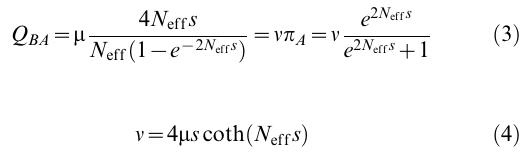
Figure S1 Phylogenetic tree of HA genomic segment for subtype H1. Avian section of the tree is in black, human in red. Found at: doi:10.1371/journal.pcbi.1000564.s002 (2.81 MB PDF) Figure S2 Phylogenetic tree of HA genomic segment for subtype H2. Avian section of the tree is in black, human in red. Found at: doi:10.1371/journal.pcbi.1000564.s003 (0.71 MB PDF) Figure S3 Phylogenetic tree of HA genomic segment for subtype H3. Avian section of the tree is in black, human in red. Found at: doi:10.1371/journal.pcbi.1000564.s004 (2.94 MB PDF) Figure S4 Phylogenetic tree of NA genomic segment for subtype N1. Avian section of the tree is in black, human in red. Found at: doi:10.1371/journal.pcbi.1000564.s005 (3.72 MB PDF) Figure S5 Phylogenetic tree of NA genomic segment for subtype N2. Avian section of the tree is in black, human in red. Found at: doi:10.1371/journal.pcbi.1000564.s006 (3.29 MB PDF) Figure S6 Phylogenetic tree of MP genomic segment. Avian section of the tree is in black, human in red. Found at: doi:10.1371/journal.pcbi.1000564.s007 (3.02 MB PDF) Figure S7 Phylogenetic tree of NS genomic segment. Avian section of the tree is in black, human in red.